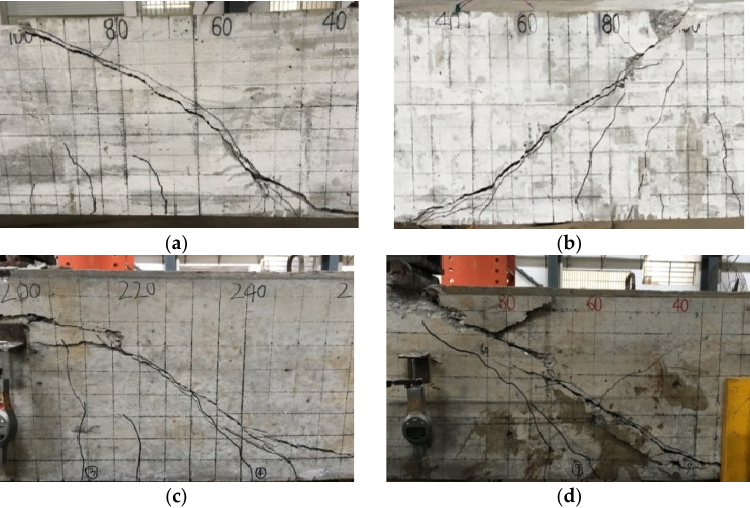
Figure 4. Failure sections of B1–B4. ( a ) B1 beam; ( b ) B2 beam; ( c ) B3 beam; ( d ) B4 beam.